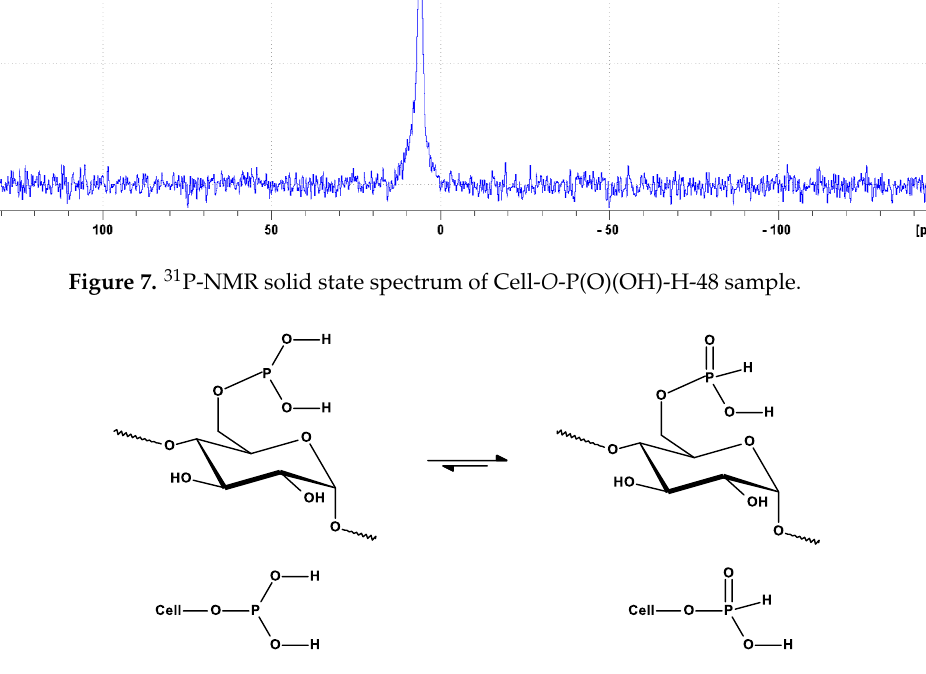
(cid:10) Cell- O - 2